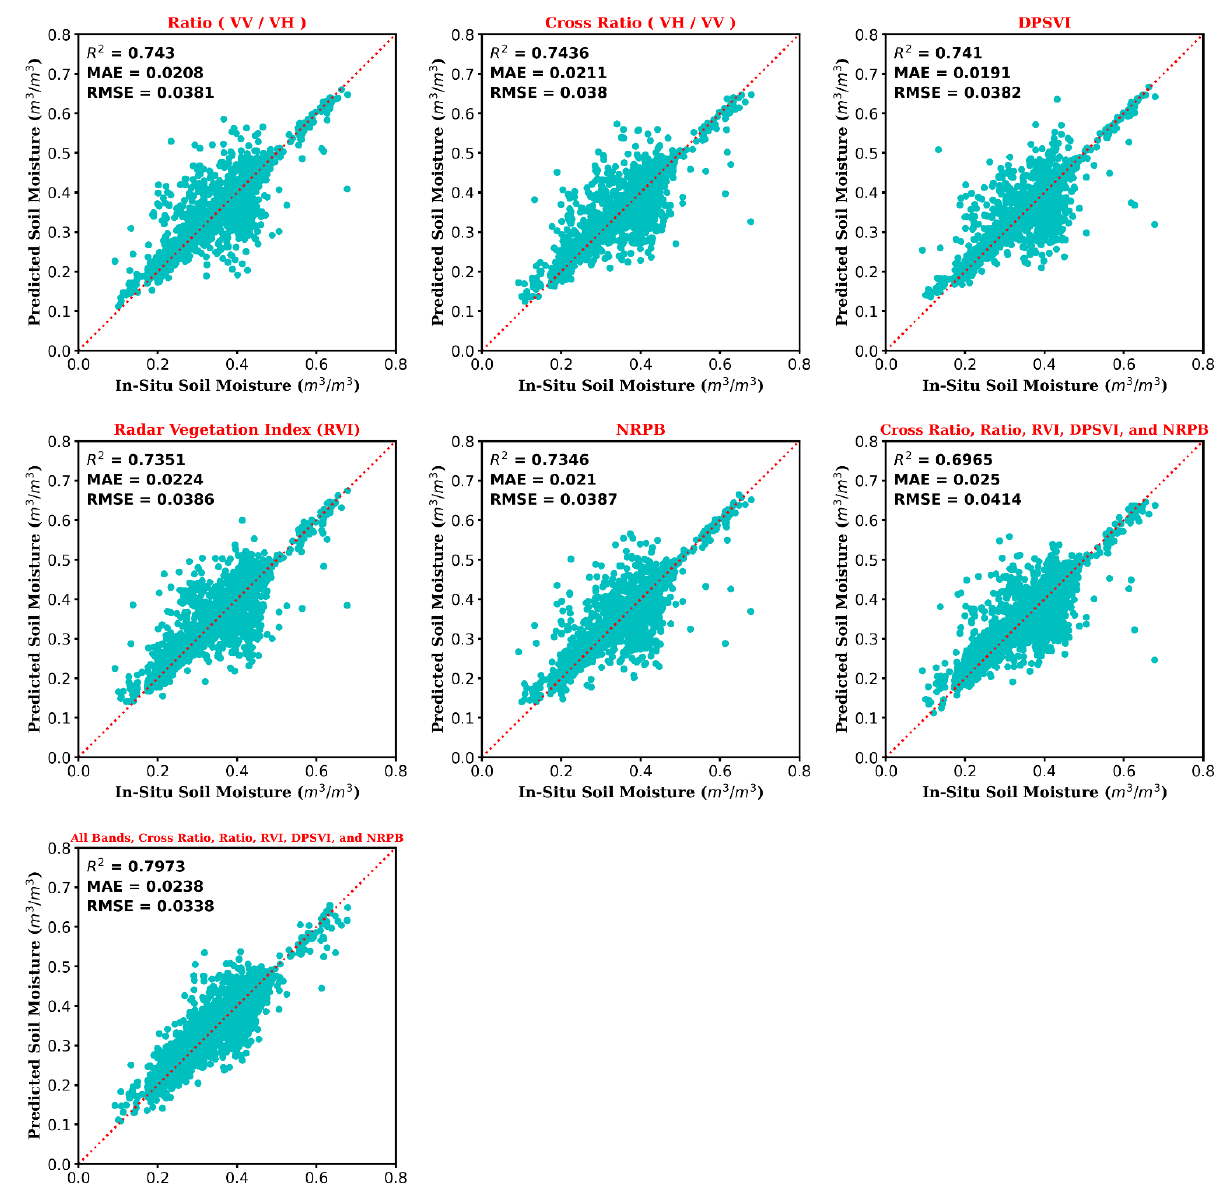
Figure 3. An illustration of the effect of indices used on the soil moisture retrieval accuracy over agricultural areas.